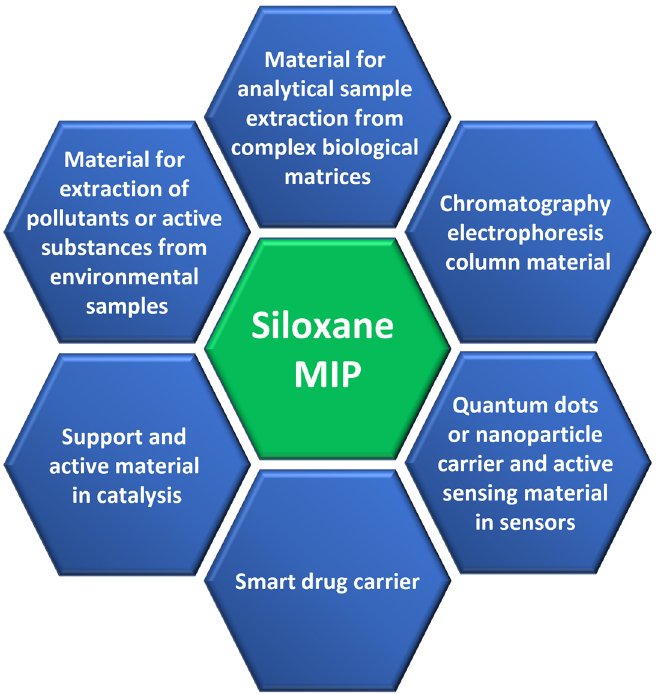
Figure 2. Application areas of siloxane molecularly imprinted polymers.